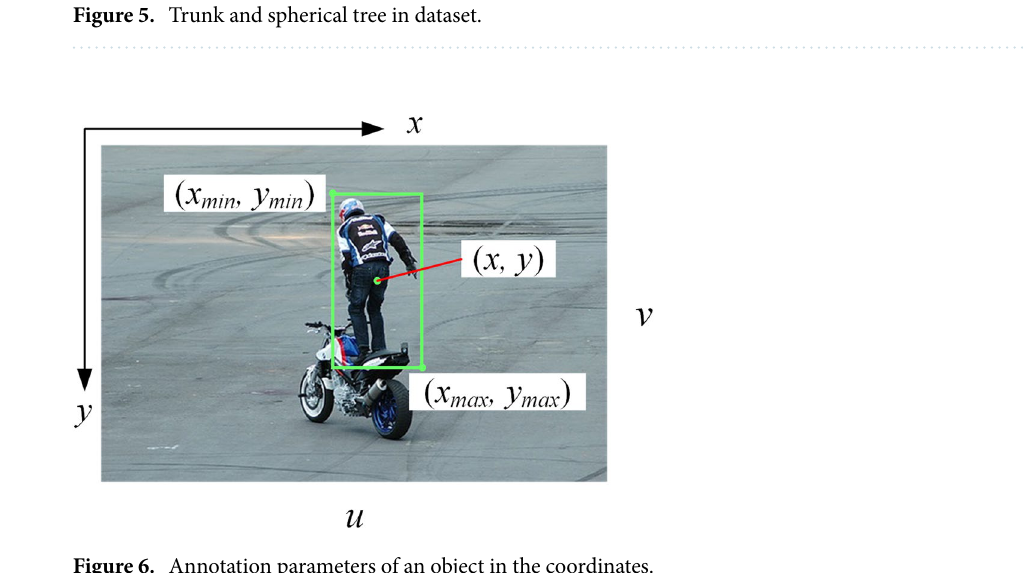
Figure 5. Trunk and spherical tree in dataset.